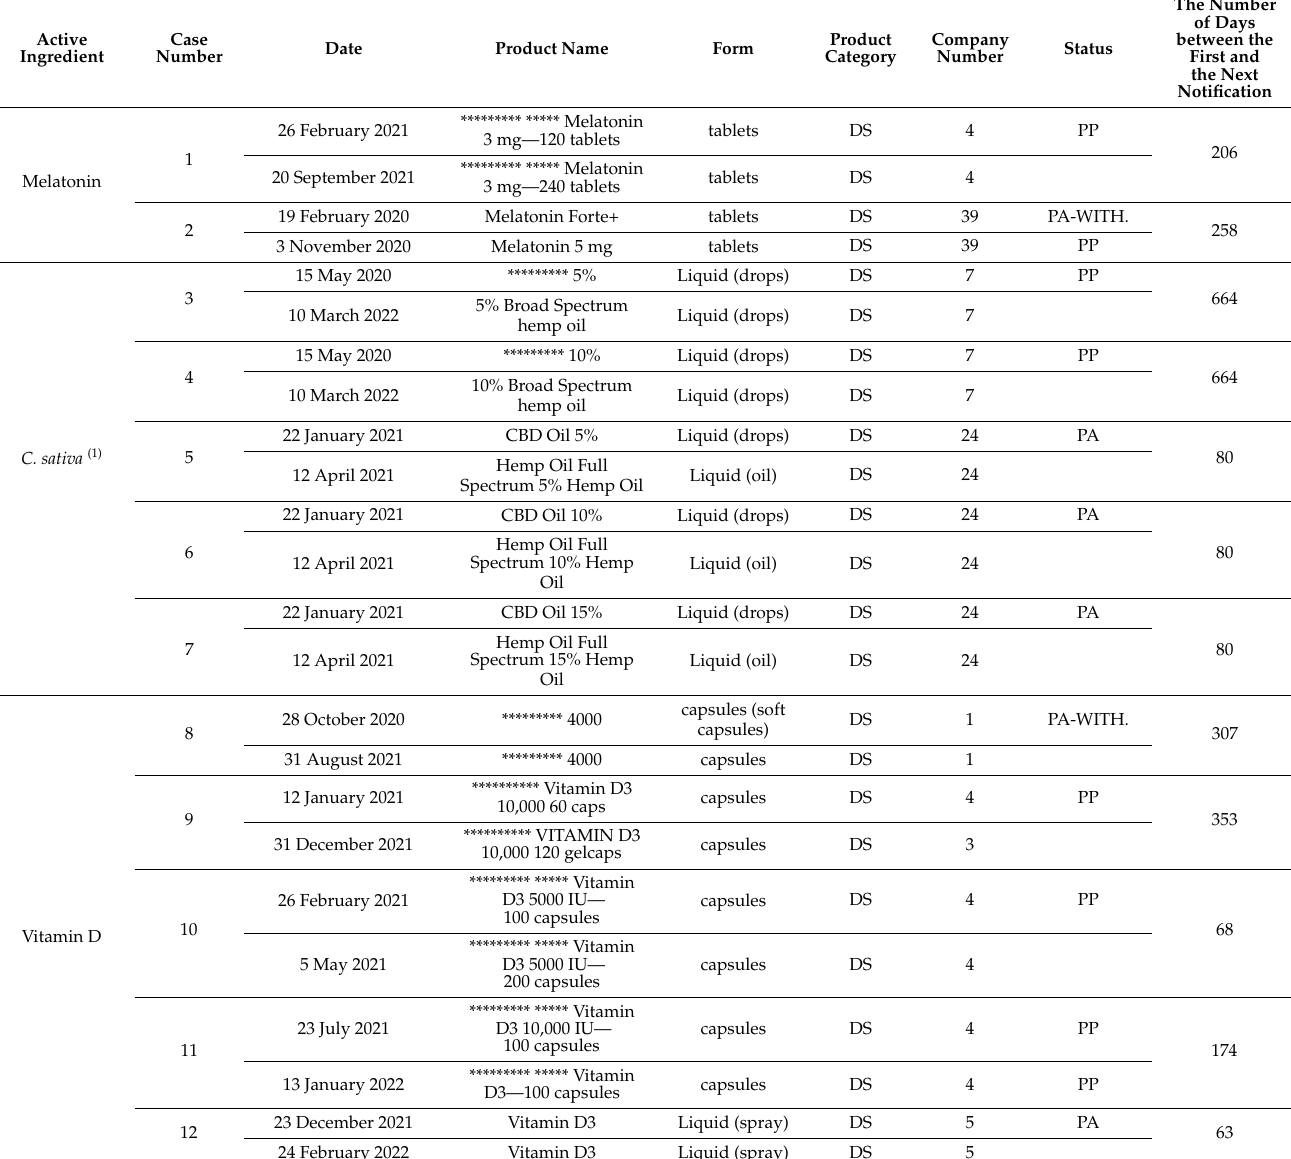
Table A1. Re-notifications of notifications of potentially the same